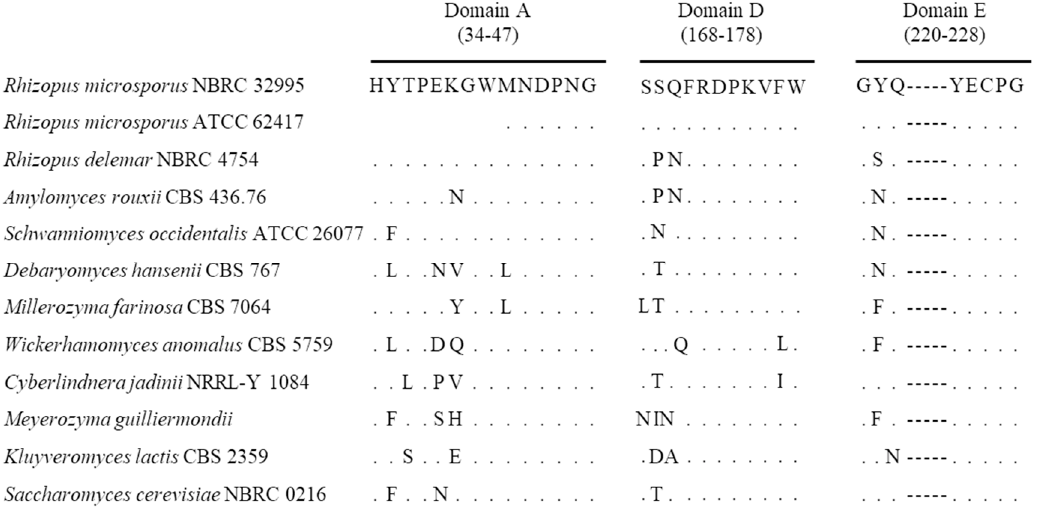
Figure 3. Conserved domains A, D, and E from microbial β -fructofuranosidases in clade VIa. Numbers in parentheses indicate positions in the enzyme from R. oryzae . Dots indicate identical amino acid residues.